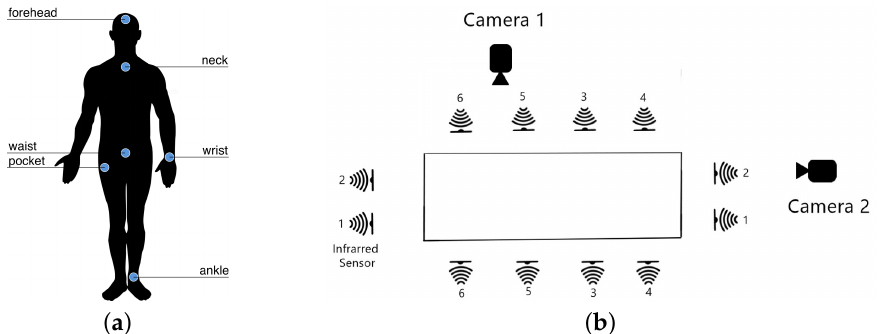
Figure 1. Distribution of the sensors. ( a ) Wearable sensors and EEG headset located at the human body. ( b ) Layout of the context-aware sensors and camera views.